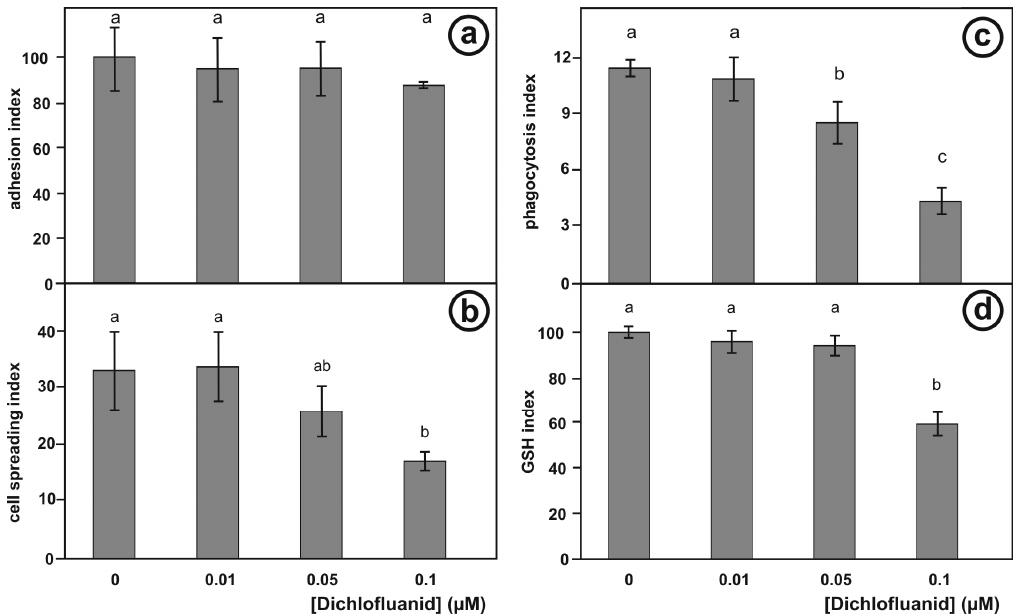
Figure 3. Adhesion index ( a ), cell spreading index ( b ), phagocytosis index ( c ) and GSH index ( d ) in the presence of various concentrations of dichlofluanid. Control (0) refers to the absence of dichlofluanid. The results are expressed, in the case of the adhesion index, as the number of living haemocytes adhering to the substrate after exposure to the dichlofluanid, and in the other cases, as the mean percentage of cells with amoeboid shape (cell spreading index), containing engulfed yeast cells (phagocytosis index) and positive staining (GSH index), ± SD (n = 3) compared to the